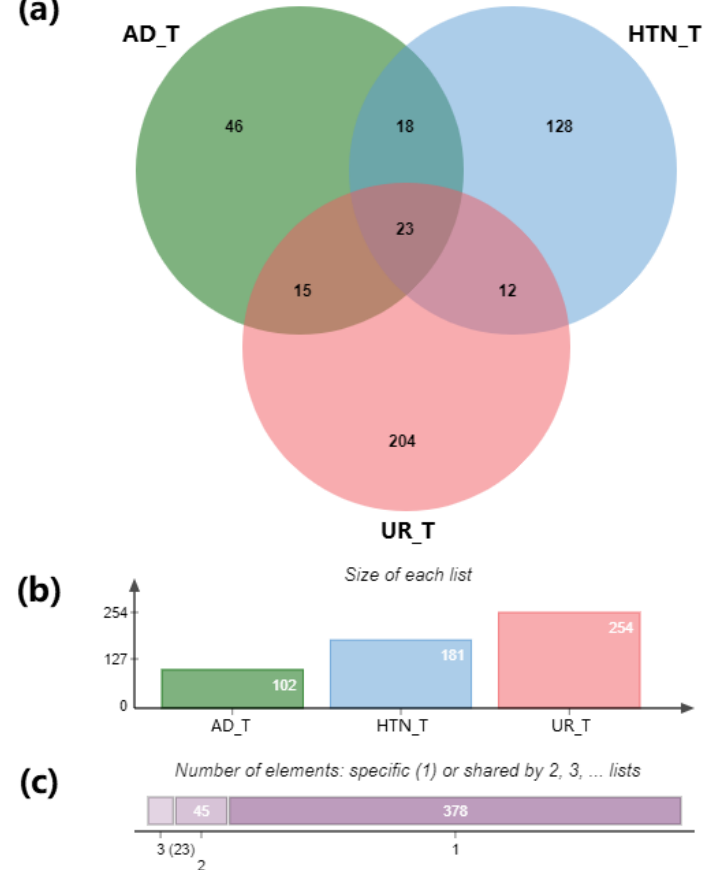
Figure 2. Analysis of the predicted compound-disease target genes among the 85 Uncaria alkaloids (UR_T), Alzheimer’s disease (AD_T), and hypertension (HTN_T). ( a ) Venn graph showing the numbers of the overlapped and the specific genes among AD, HTN, and UR; ( b ) numbers of predicted genes from each set; ( c ) a summary of numbers of genes shared among the gene sets: 378 specific genes, 45 genes shared by two sets, and 23 genes found in all three sets of genes.